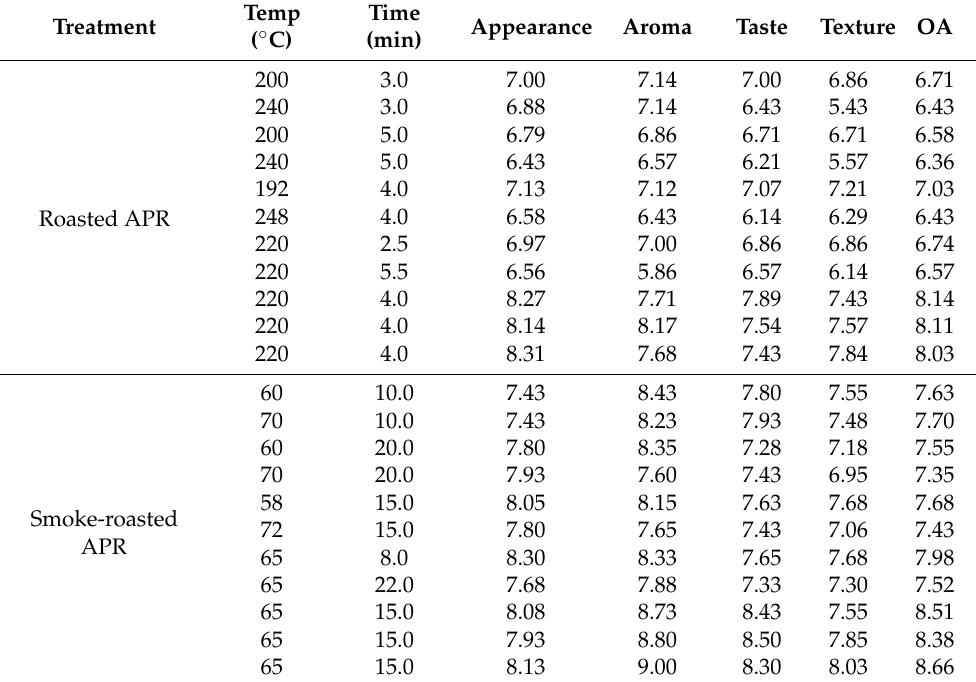
Table 3. Appearance, aroma, taste, texture, and overall acceptance (OA) of roasted and smoke-roasted Alaska pollack roe (APR) in a central composite